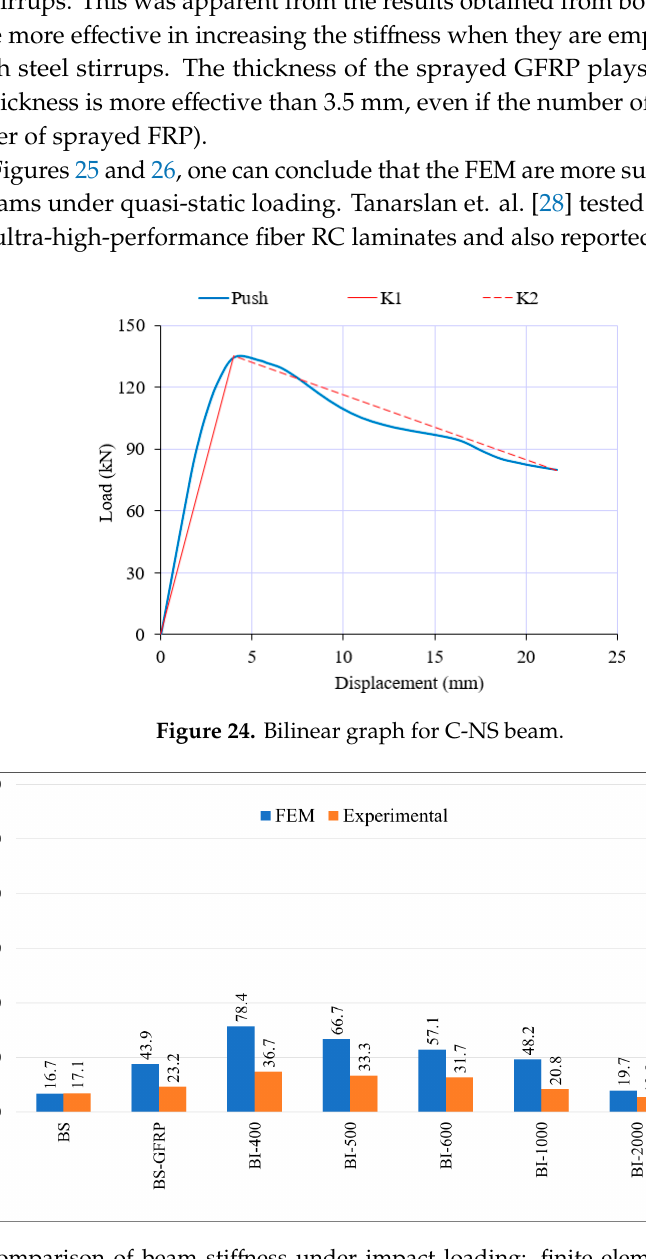
Figure 25. Comparison of beam stiffness under impact loading: finite element model (FEM) vs. experimental results.